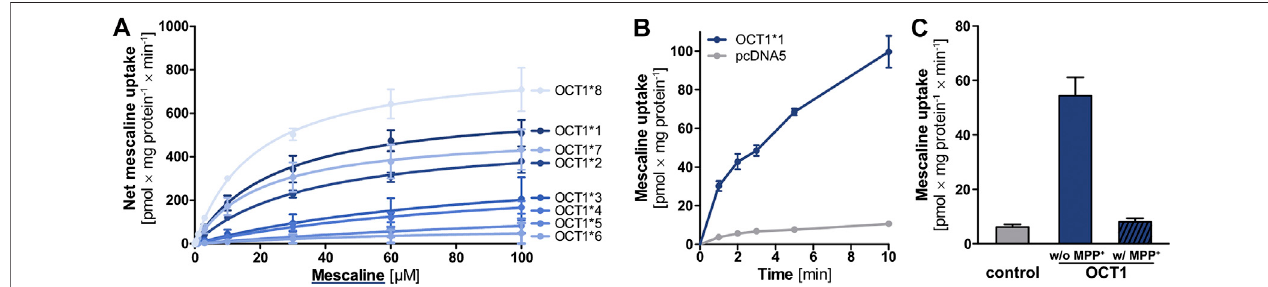
FIGURE 4 | (A) Transport of mescaline at different concentrations by OCT1*1 (wild-type) and genetic variants, shown as the cellular uptake in transporter- overexpressingcellswithsubstracteduptakeinnon-overexpressingcontrolcells.Shownarethemeanvaluesof ≥ 3independentexperiments ± SEM.K m andv max values are given in Table 2 . (B) Time-dependent uptake of 1 µM mescaline in OCT1*1-overexpressing (blue) and non-overexpressing control (pcDNA5, gray) cells, shown as the mean values of 3 independent experiments ± SEM (C) Mescaline transport by OCT1 could be completely inhibited by 1 mM MPP + to values not signi fi cantly